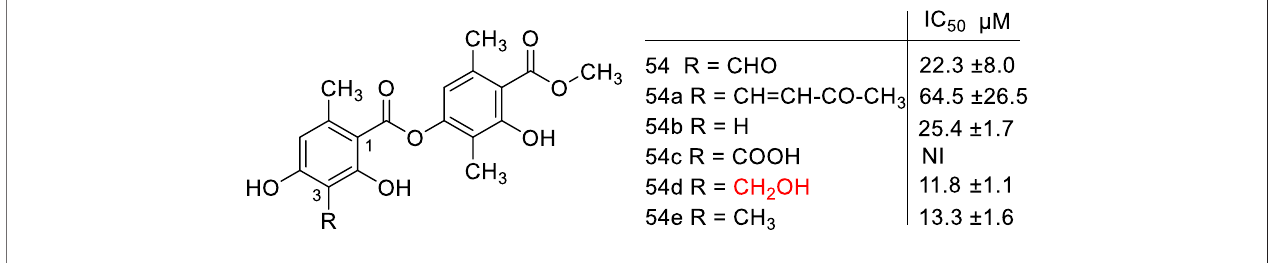
FIGURE 4 | Atranorin ( 54 ) and its derivatives ( 54a – e